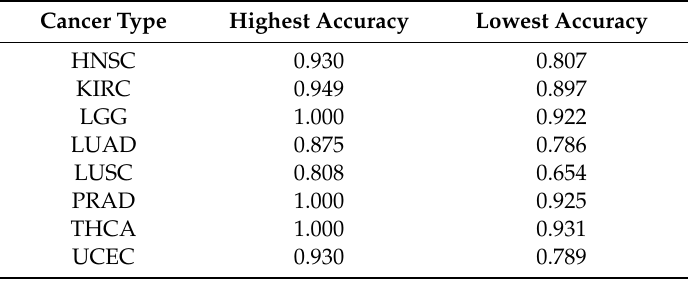
Table 2. The lowest and highest accuracies for each cancer type yielded by the optimal SVM classifier on each of ten folds.